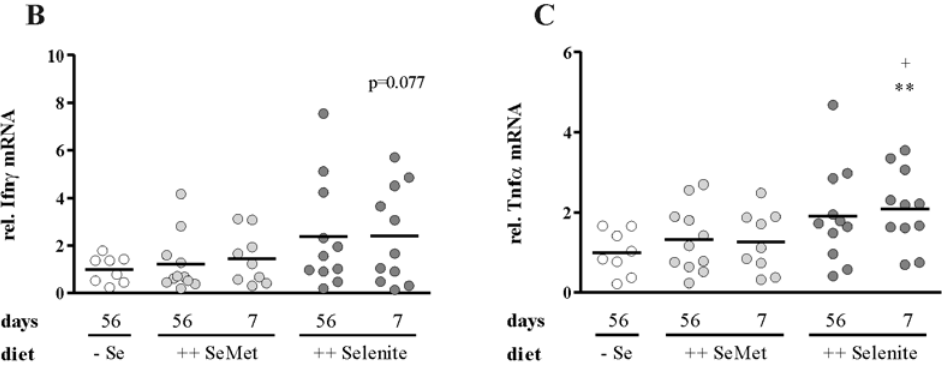
Figure 4. Transcript levels of pro-inflammatory markers are upregulated by short-term selenite supplementation. Colonic mRNA expression of ( A ) Cox2, ( B ) Ifnγ and ( C ) Tnfα was measured by qPCR and normalized to Rpl13a. Each point represents one mouse. Lines indicate means. Significant differences were calculated by Student’s t -test. * p < 0.05,